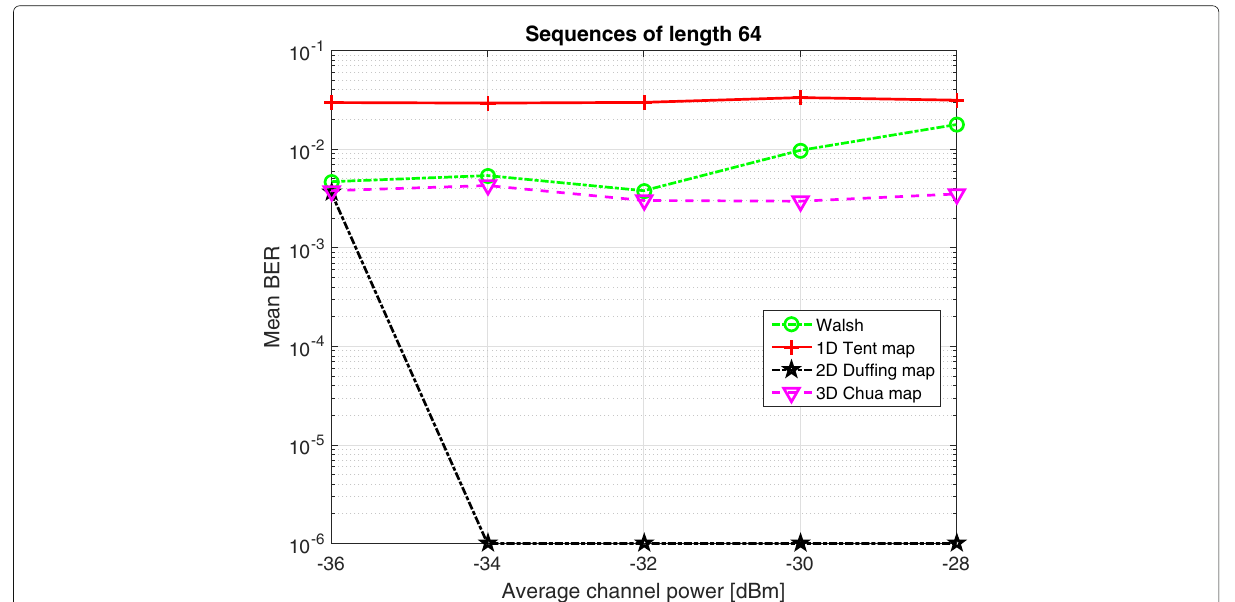
Fig. 9 Mean BER against against average channel power for sequences of length